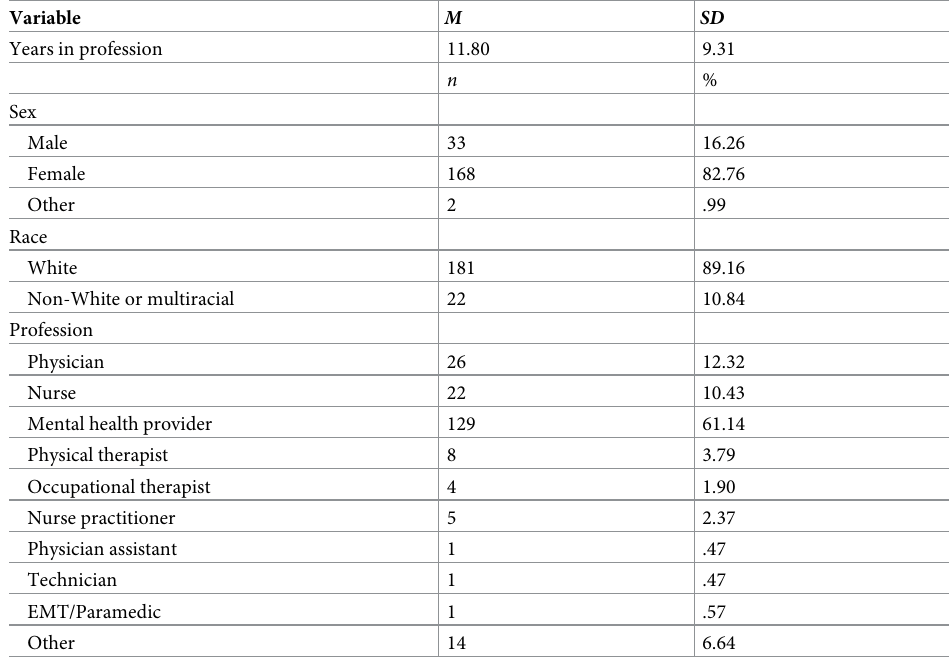
Table 1. Sociodemographic and work-related sample characteristics (N = 211).